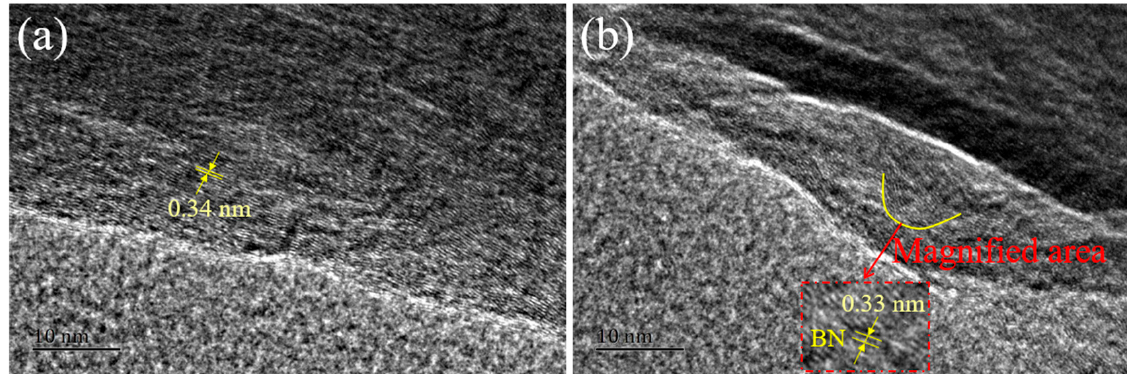
Figure 2. HRTEM images of carbon ( a ) and BN ( b ) in the B,N-CNT-4.